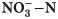
Mean NO3‐‐N content in the 0–60 cm soil depth band from 5 to 90 days after fertilization.CK, no N fertilizer input; CF, conventional fertilization; 80%U+UI, 80%U+NI and 80%U+1/2(UI+NI) indicate 80% of urea input with NBPT, with DMPP and with half NBPT and half DMPP, respectively. Vertical bars represent LSD0.05 between treatments.